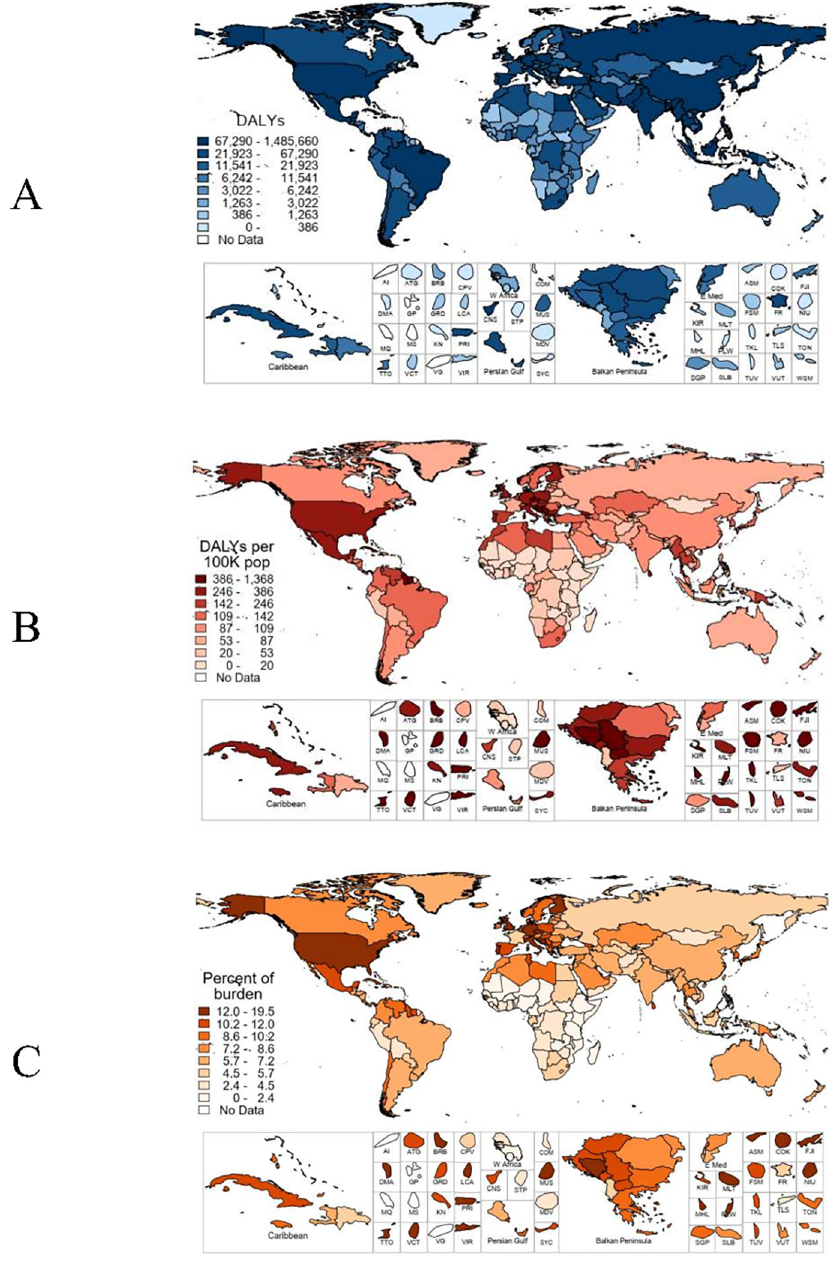
Fig 4. Country level non-communicable disease burden attributable to zinc deficiency: (A) total DALYs, (B) DALYs per 100,000 people, (C) Percent of high FPG disease burden attributable to zinc deficiency. (Map base layer: https:// hub.arcgis.com/datasets/UIA::uia-world-countries-boundaries/about).